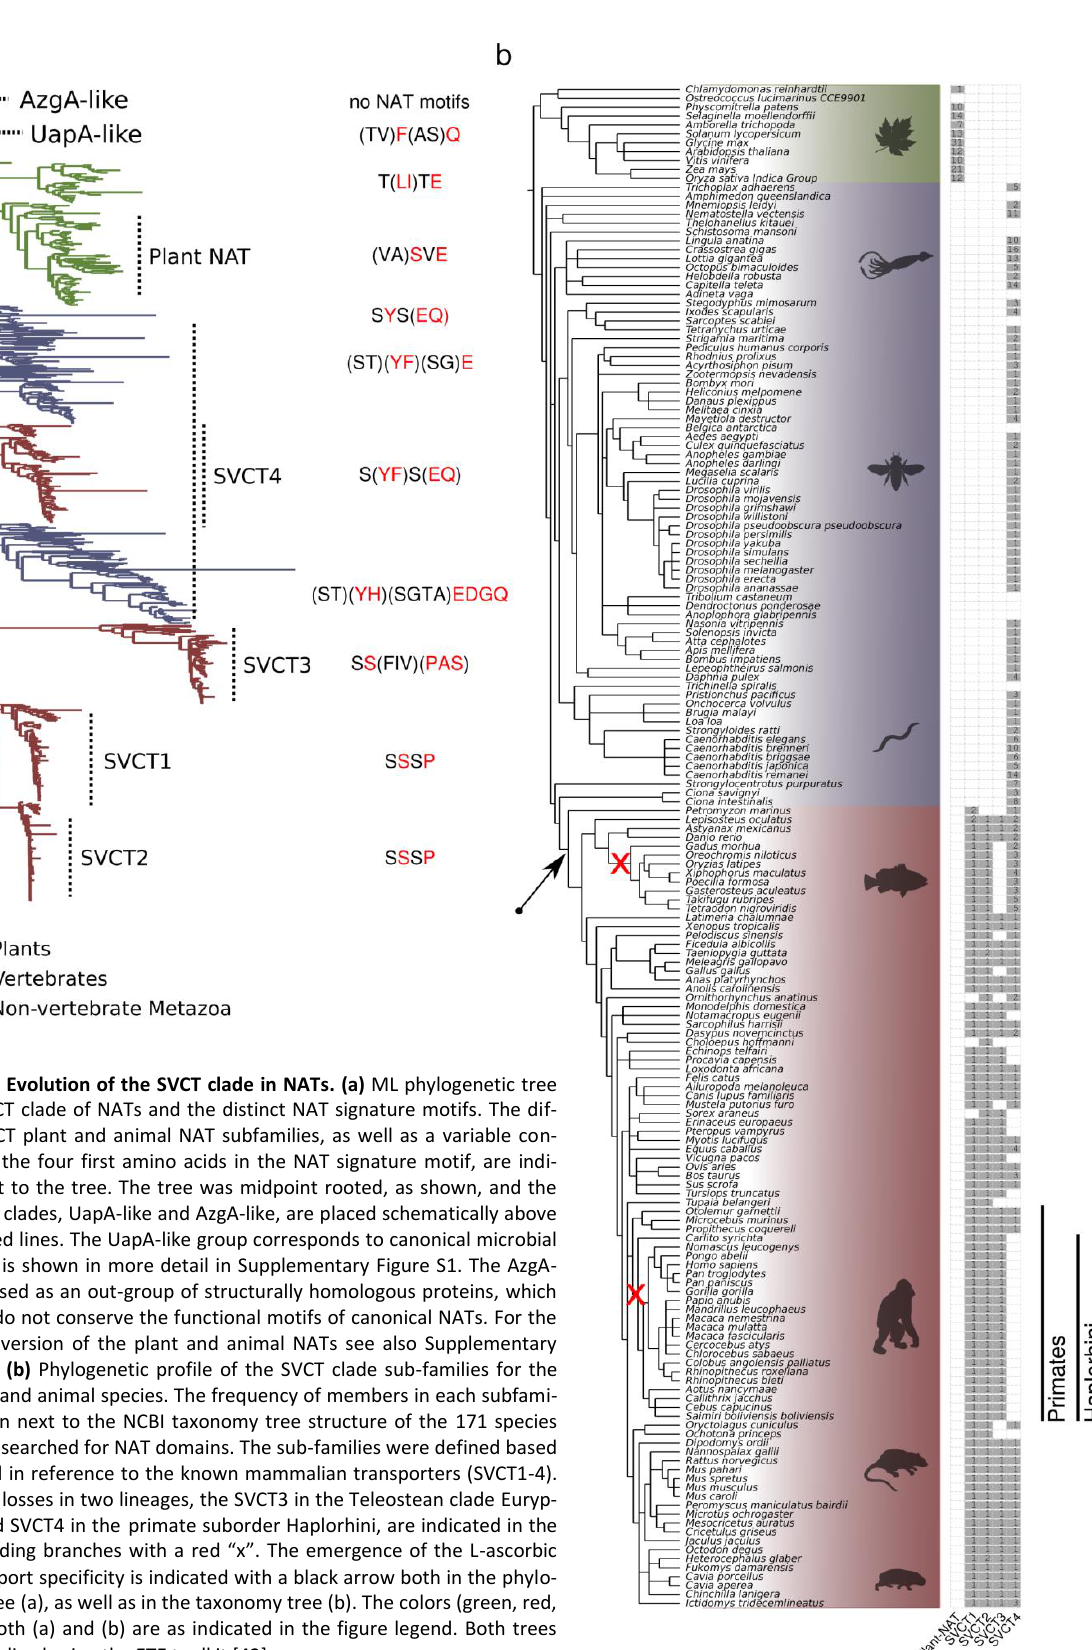
OPEN ACCESS | www.microbialcell.com 284 Microbial Cell | JUNE 2018 | Vol. 5 No. 6